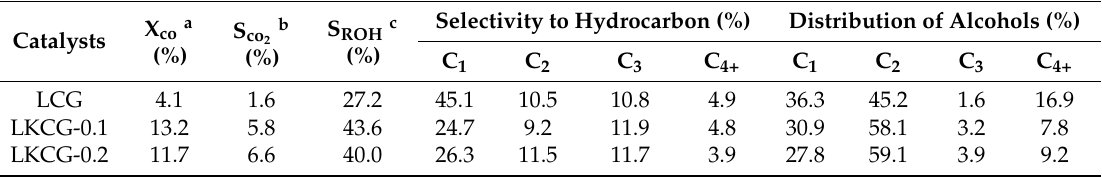
Table 4. CO hydrogenation performance of the investigated catalysts.